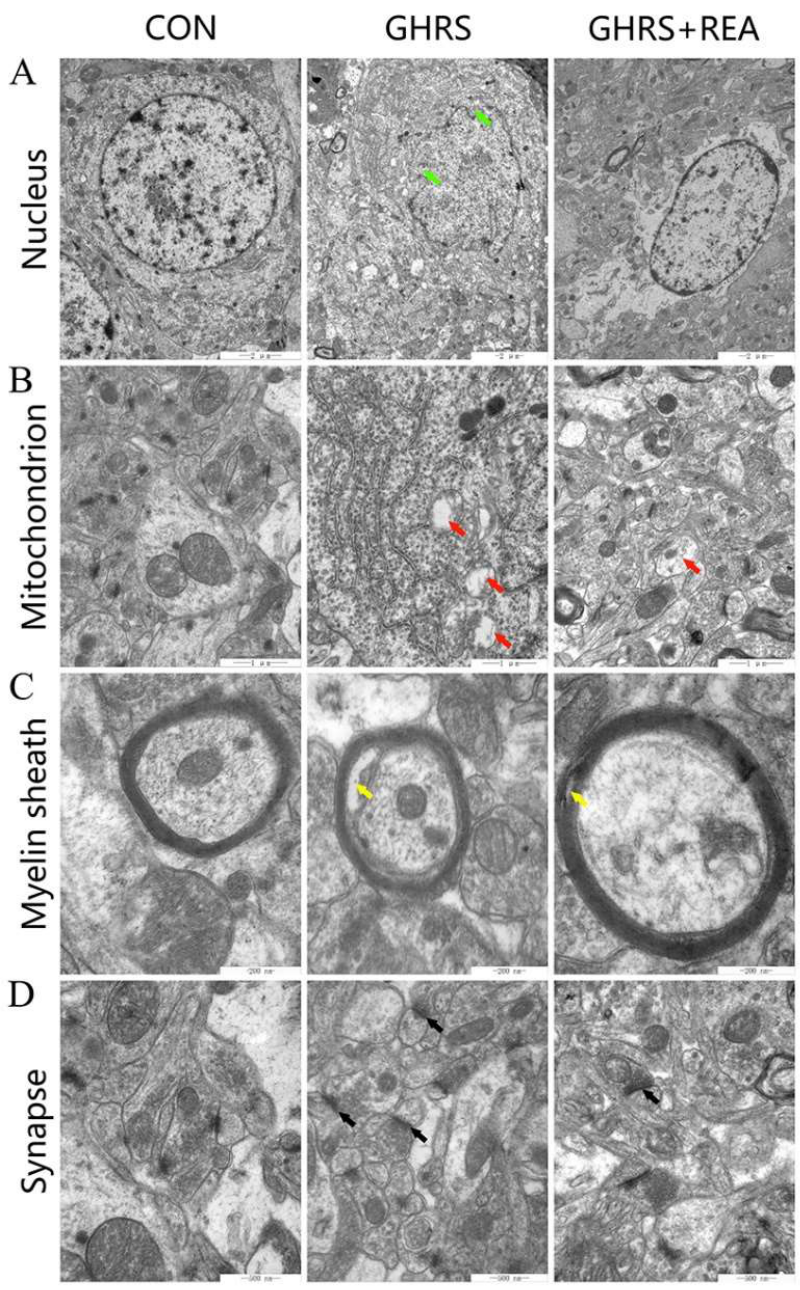
Figure 2. The ultrastructure of hippocampal neurons in rats. ( A ) Results showing the ultrastructure of neuron nucleus; the scale is 2 μm. ( B ) The ultrastructure of the mitochondria; the scale is 1 μm. ( C ) The ultrastructure of myelin sheath; the scale is 200 nm. ( D ) The ultrastructure of the synapse; the scale is 500 nm. The green arrows represent interrupted nuclear membrane, red arrows show mitochondria swelling and vacuolation, yellow arrows show mild demyelination, and black arrows represent postsynaptic membrane thickening.